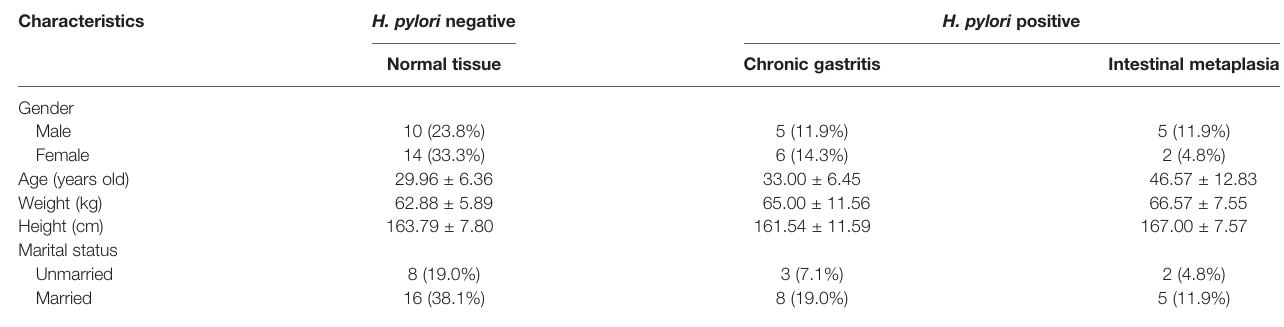
TABLE 1 | Demographic characteristics of enrolled patients.